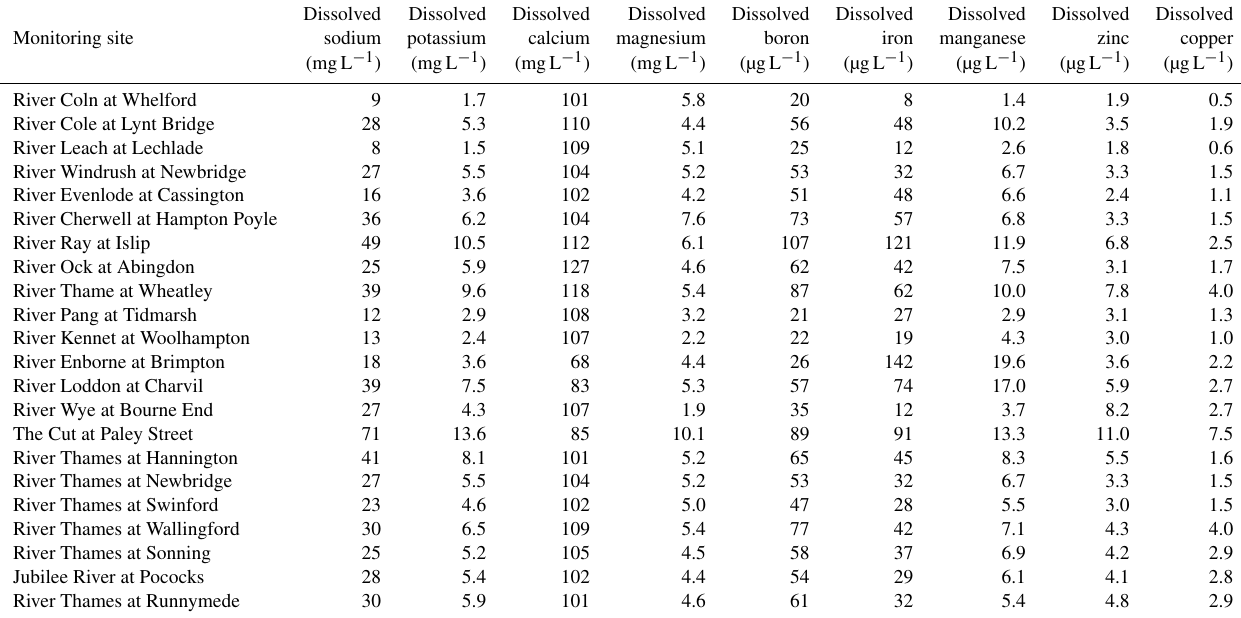
Table 4. Mean cation concentrations from March 2009 to February